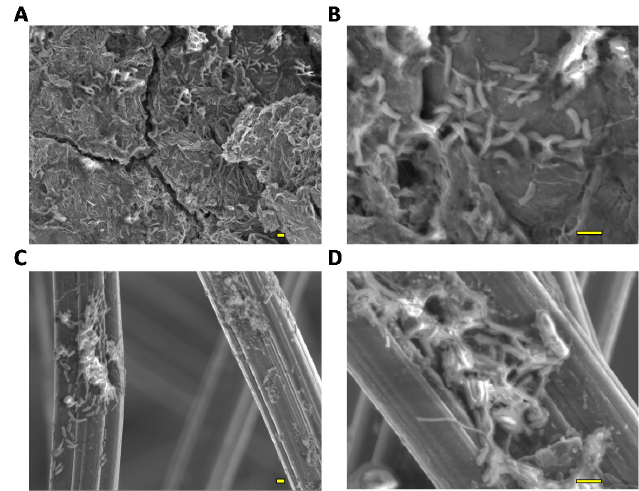
Figure 4. SEM images of biofilm growth on the rGO ( A , B ) and GF complexes ( C , D ). Scale bars on images indicate 1 μ m. Table 1. Biomass comparison in the rGO and GF complexes before and after polarization. Cell